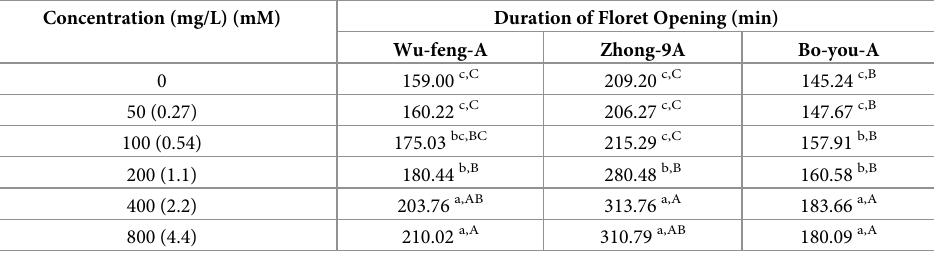
Mean values within a column were analyzed with Duncan new multiple range test. Values in a column with different letters indicate a significant difference among the treatments. Uppercase and lowercase letters represent significant differences at ρ = 0.01 and ρ = 0.05,